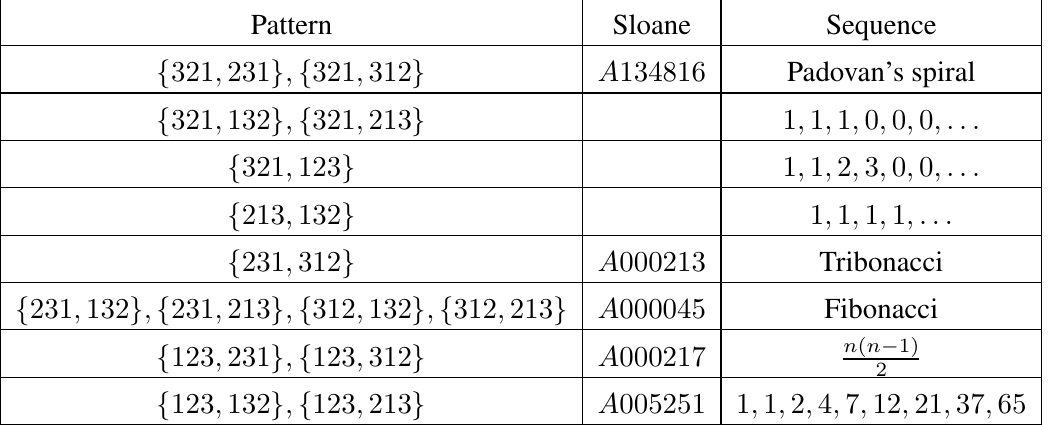
Tab. 2: Wilf-equivalence classes for two pattern subsets of S 3 in irreducible